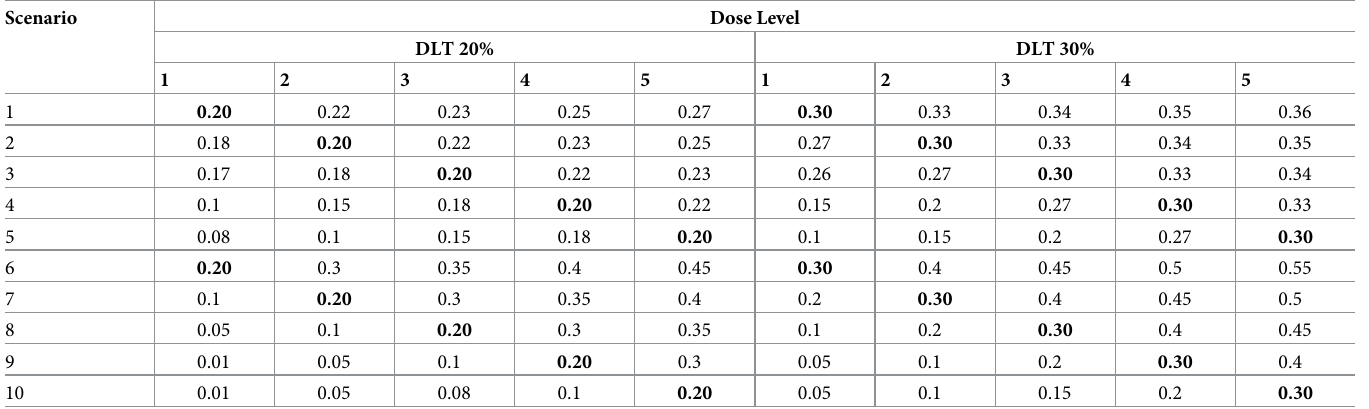
Table 2. Ten true toxicity scenarios with the target DLT rate of 20% and 30%.